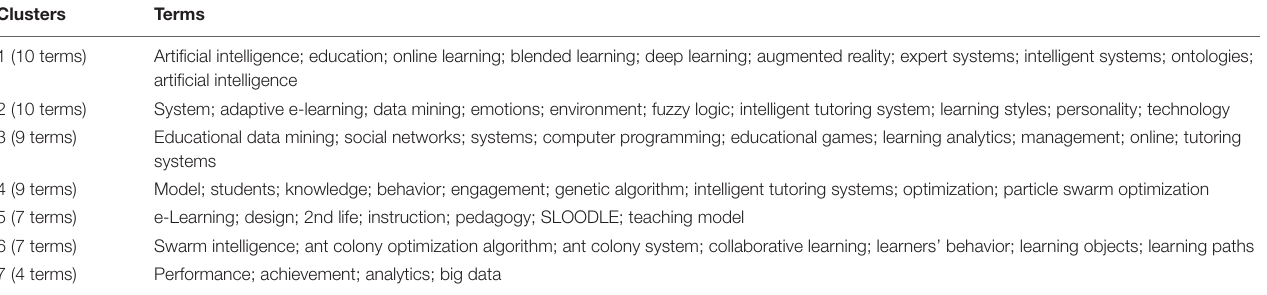
FIGURE 4 | Roles of AIEL research. TABLE 5 | Cluster